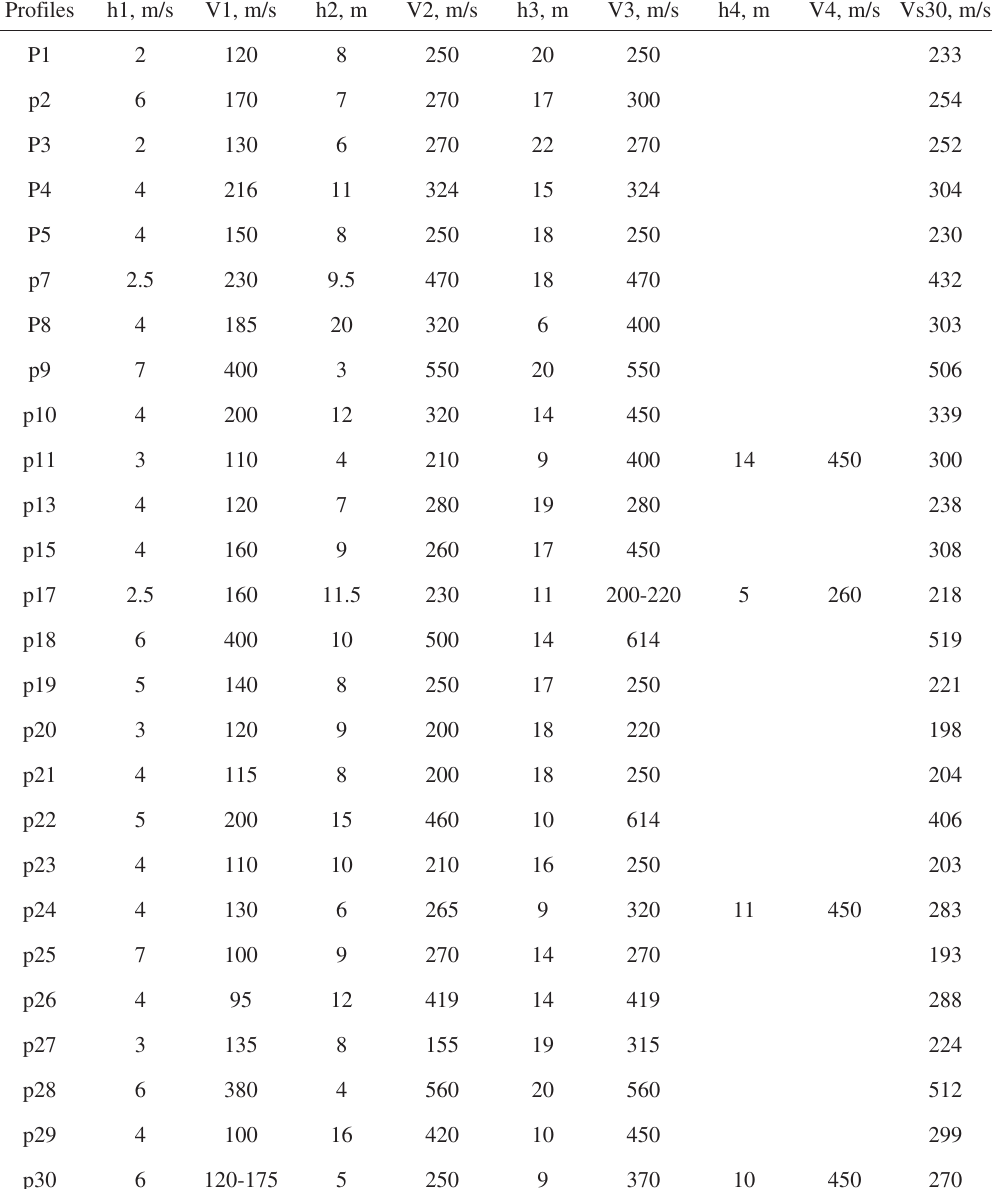
Table IV . S-wave velocities in refraction